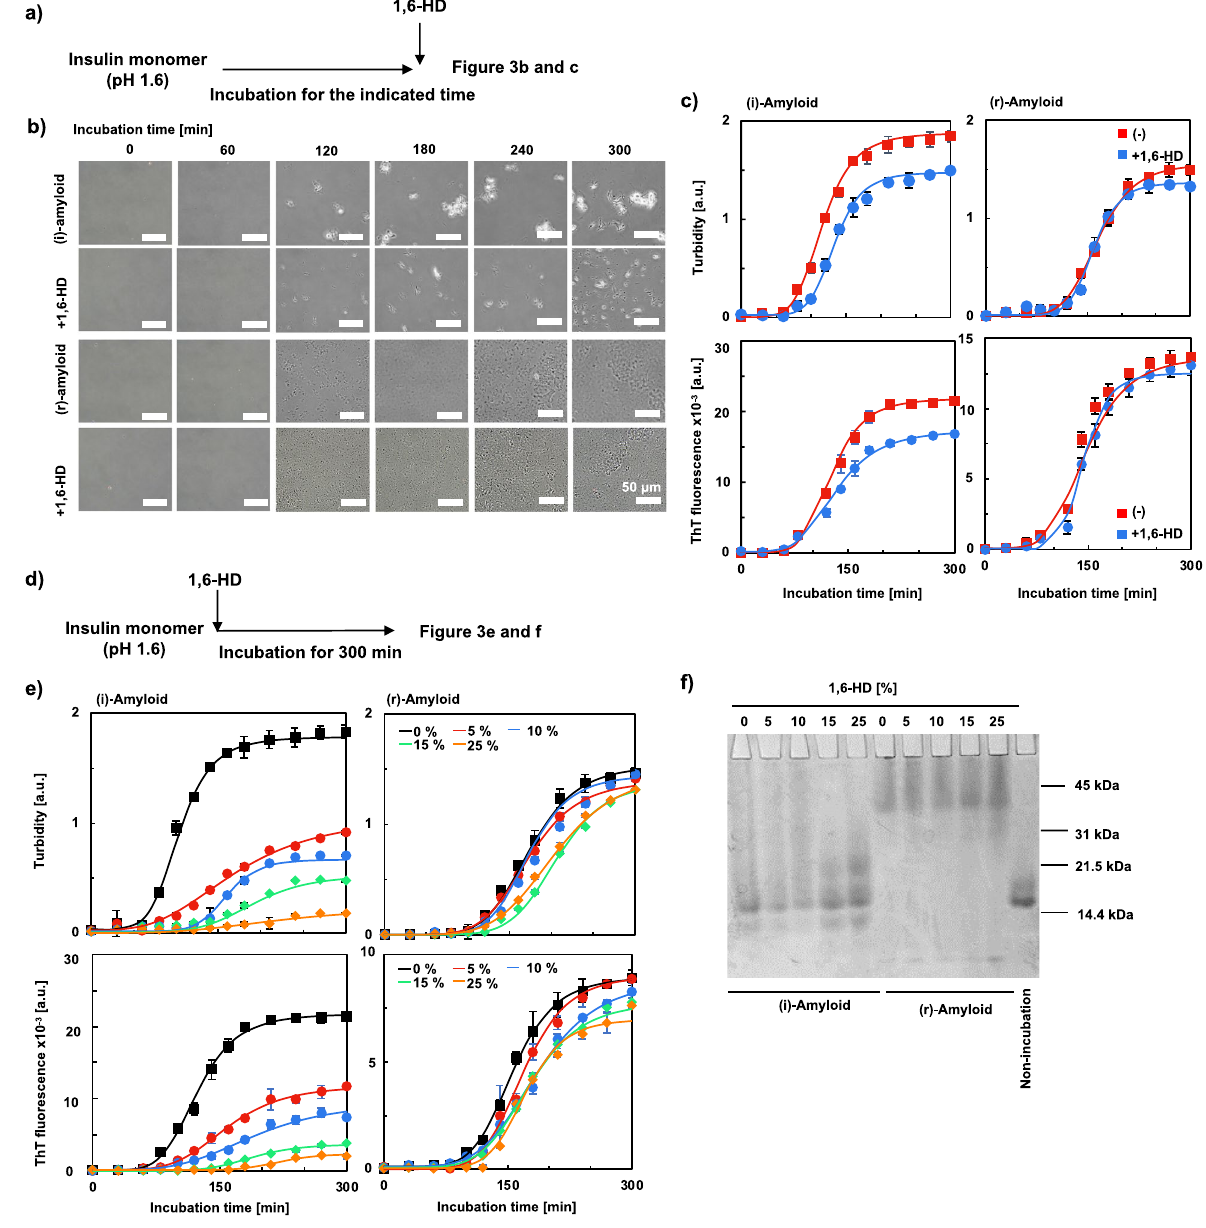
Figure 3. Evaluation of the effect of 1,6-HD on the formation of insulin amyloids. ( a ) Experimental scheme of ( b ) and ( c ). ( b ) Images of insulin amyloids were observed using an optical microscope. Insulin was incubated for the indicated periods ((i)-amyloids, top; (r)-amyloids, third from the top), were observed after the additives of 5% 1,6-HD ((i)-amyloids: second from the top, (r)-amyloids: fourth from the top). The scale bar is 50 μm. ( c ) Turbidity (upper) and ThT assay (lower) of (i)-amyloid (left) and (r)-amyloid (right)(red) measured after adding 5% 1,6-HD (blue). Peak fluorescence values at 490 nm (ThT). Protein concentrations were adjusted to 5 µM. ( d ) Experimental scheme of ( e ) and ( f ). ( e ) (i)-amyloid (left) and (r)-amyloid (right) were formed in the absence (black) and presence of 5, 10, 15, 25% 1,6-HD (red, blue, green, and orange, respectively), and were evaluated by turbidity (upper) and ThT assay (lower). Peak fluorescence values at 490 nm (ThT). Protein concentrations were adjusted to 5 µM. ( f ) Native-PAGE analysis of 150 μM (i)-amyloids and (r)-amyloids formed in the absence and presence of 5, 10, 15, 25% 1,6-HD. The rightmost sample is an unincubated native